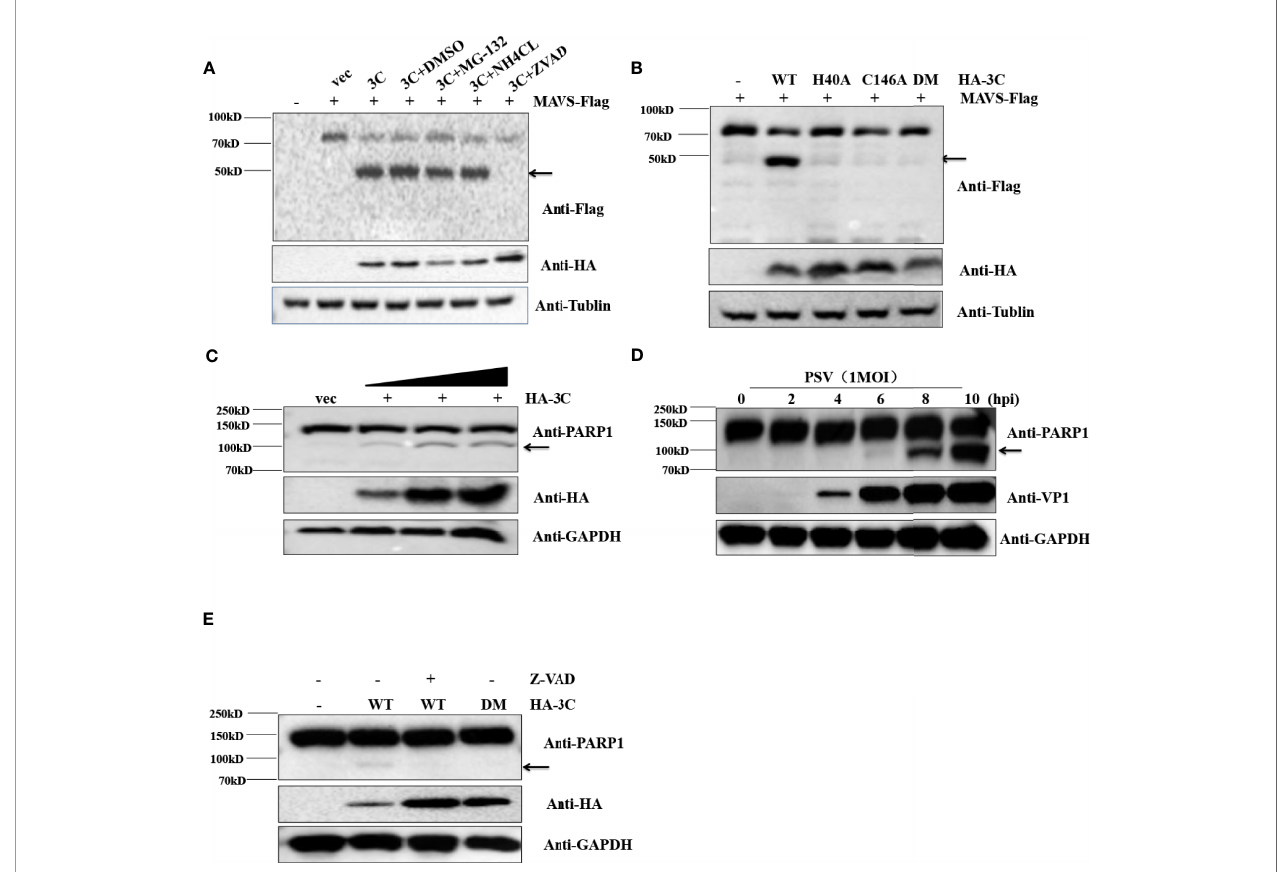
FIGURE 6 | PSV 3C pro cleaves MAVS through the apoptosis pathway. (A) HEK293T cells were seeded in 12-well plates and co-transfected with 500 ng Flag-MAVS and HA-3C for 12 h, then the cells were treated with DMSO, MG132, NH 4 Cl, and Z-VAD-FMK for 12 h. The cells were then collected for Western blotting. (B) The monolayer HEK293T cells in 12-well plates were co-transfected with 500 ng Flag-MAVS and HA-3C or HA-3C-mutant. At 24 hpt, the cells were collected and lysed for Western blotting. (C) HEK293T cells were infected with 0.5 MOI PSV for the indicated times, and then the cells were collected and lysed for Western blotting. (D) HEK293T cells were transfected with different doses of HA-3C (0.5 m g, 1 m g, 2 m g) for 24 h, and then the cells were collected and lysed for Western blotting. (E) HEK293T cells were transfected with 500 ng HA-3C or its mutant for 12 h. The Z-VAD-FMK (50 m M) were added and maintained in the cells for another 12 h, and then the cells were collected and lysed for Western